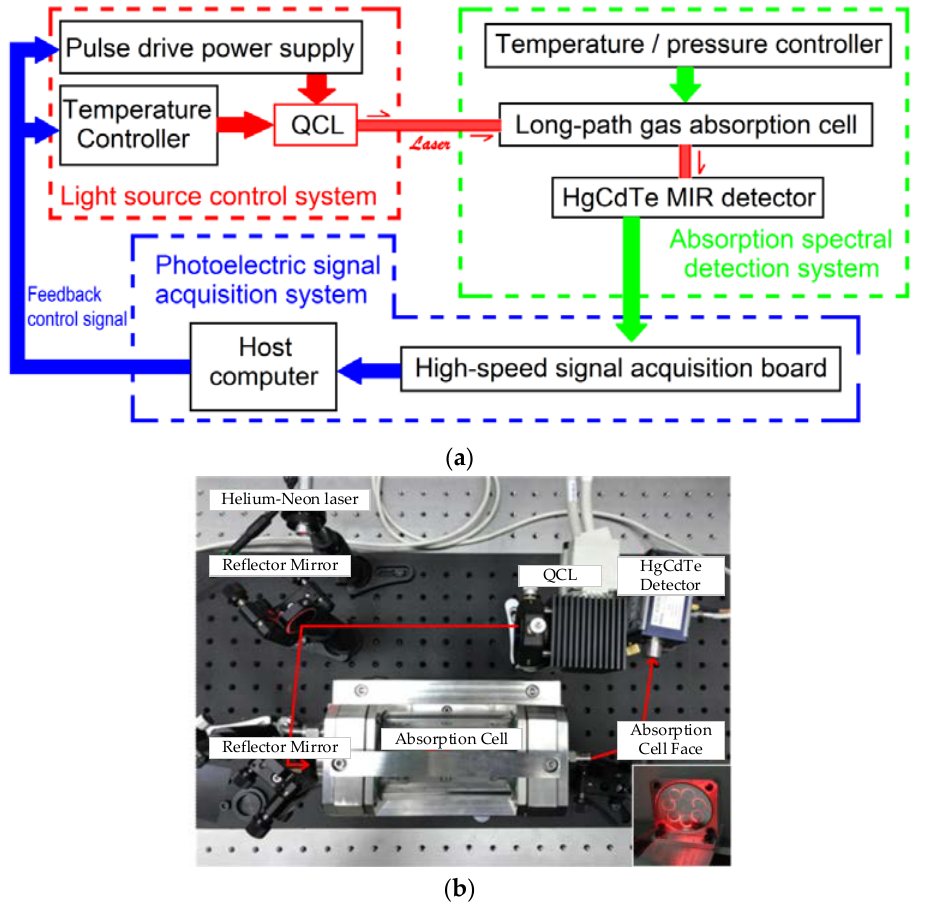
Figure 2. ( a ) The block diagram of CO sensor. ( b ) Physical image of CO sensor 106